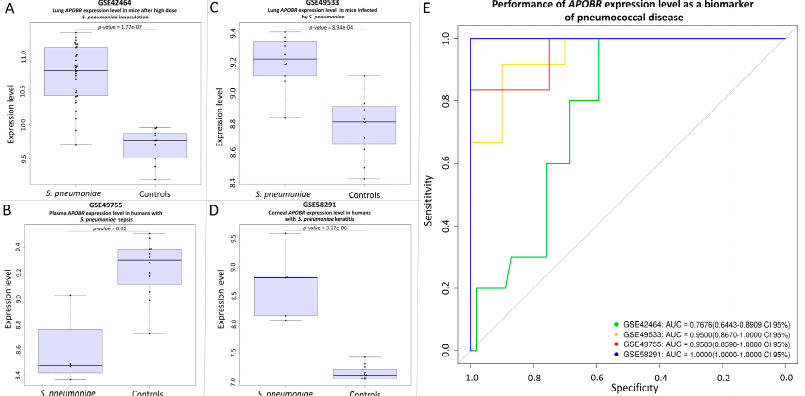
Figure 6. ( A ) Differential lung expression level of the APOBR gene between healthy mice and S. pneumoniae infected mice in the study GSE42464. ( B ) Plasma expression level of the APOBR gene between healthy human control and S. pneumoniae sepsis patients in the study GSE49755. ( C ) Lung expression level of the APOBR gene between healthy mice and S. pneumoniae infected mice in the study GSE49533. ( D ) Differential expression level of the APOBR gene between corneal tissue from corpses and S. pneumoniae keratitis patients in the study GSE58291. ( E ) ROC evaluating the potential of the APOBR gene as a biomarker in the studies GSE42464, GSE49755, GSE49533, and GSE58291.